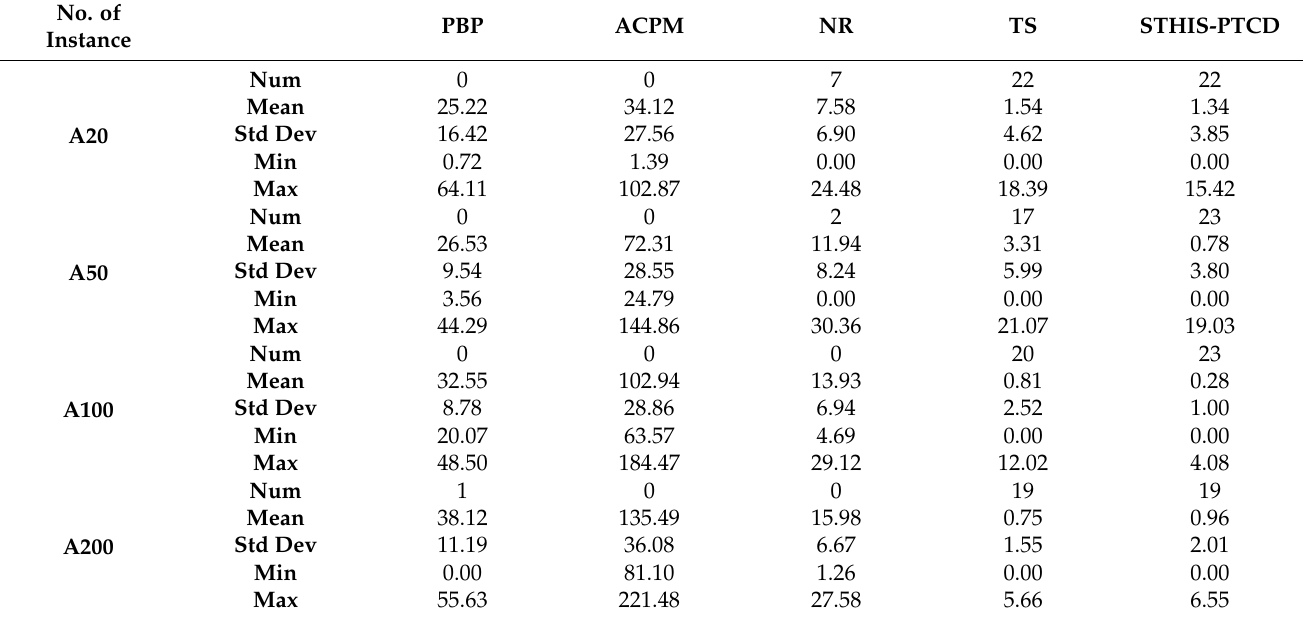
Table 5. Descriptive statistics based on RDI.